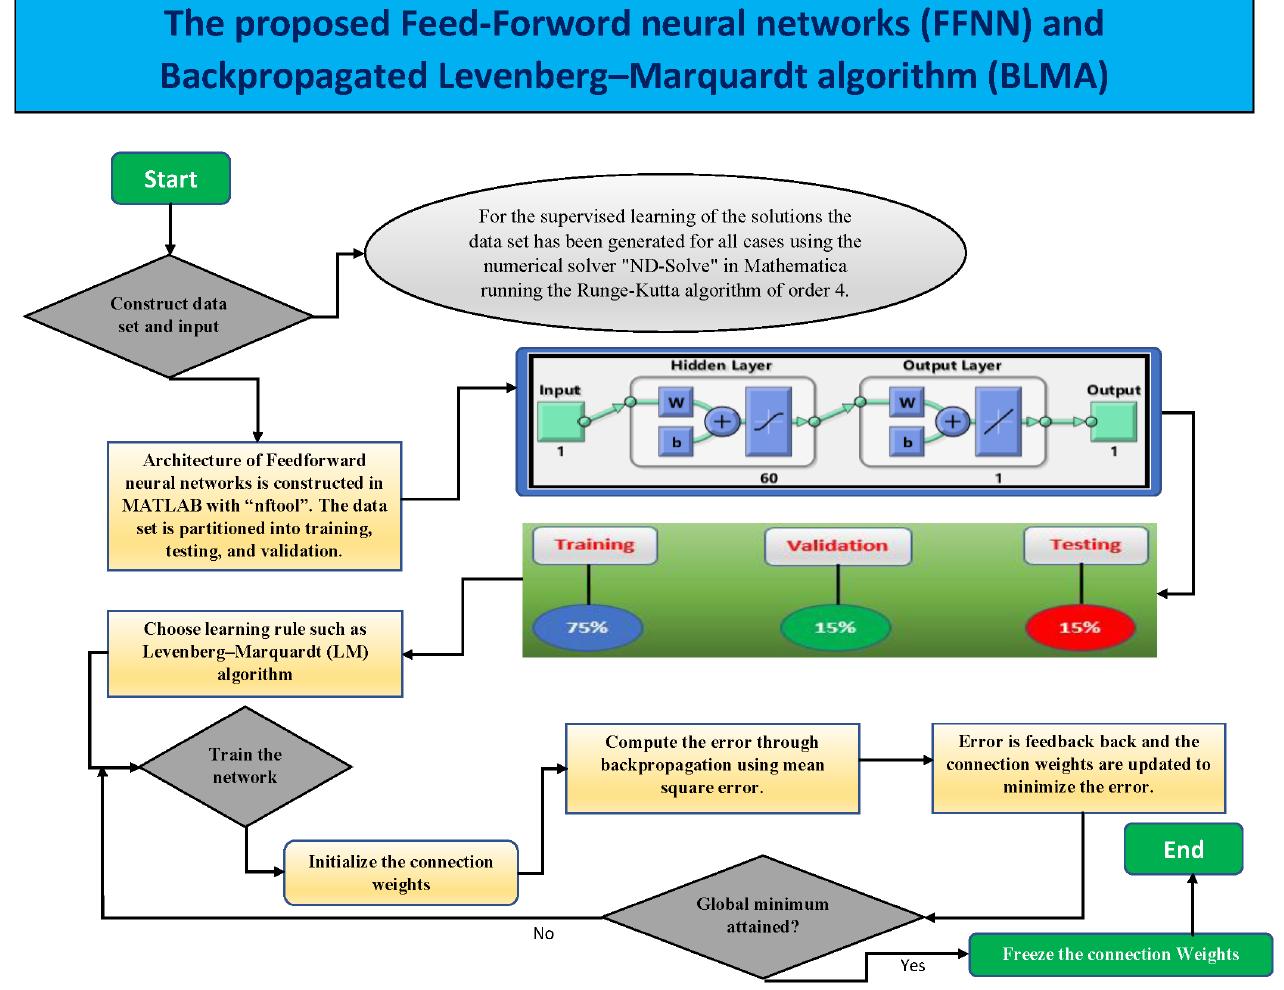
Figure 3. The algorithm was designed according to the following operational